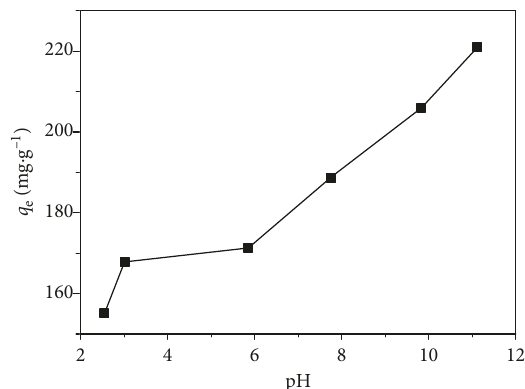
Figure 8: Effect of pH on the adsorption of methylene blue on the optimal activated carbon ( C 0 � 50mgL − 1 ; contact time � 180min; adsorbent dose � 0.2g L − 1 ; T � 15 °